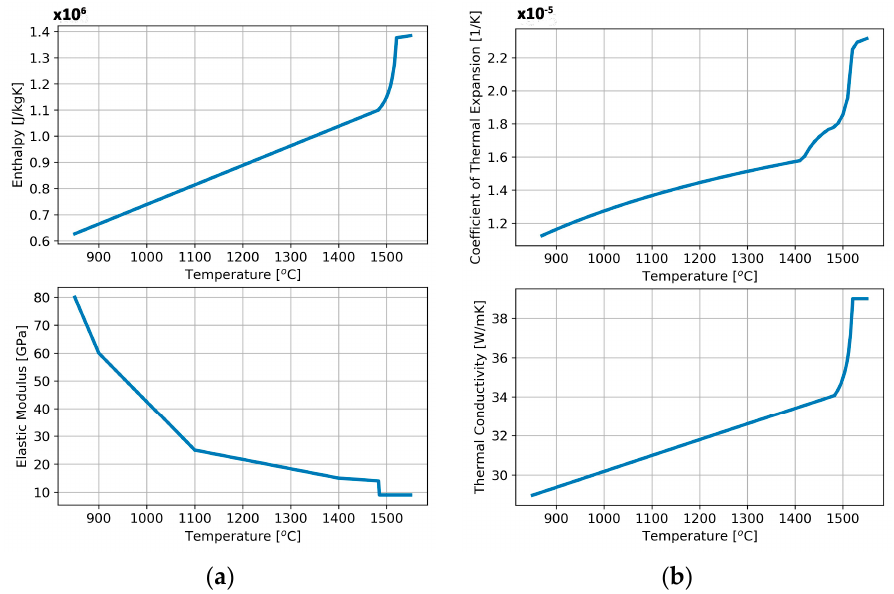
Figure 2. Temperature dependent material properties for 0.09 wt%C steel grade: ( a ) elastic modulus and enthalpy and ( b ) thermal conductivity and thermal expansion.